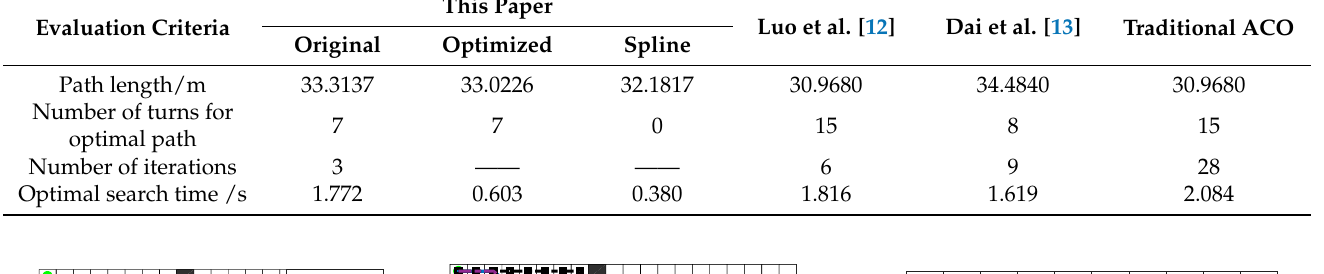
Table 4. General environment algorithm performance comparison table.